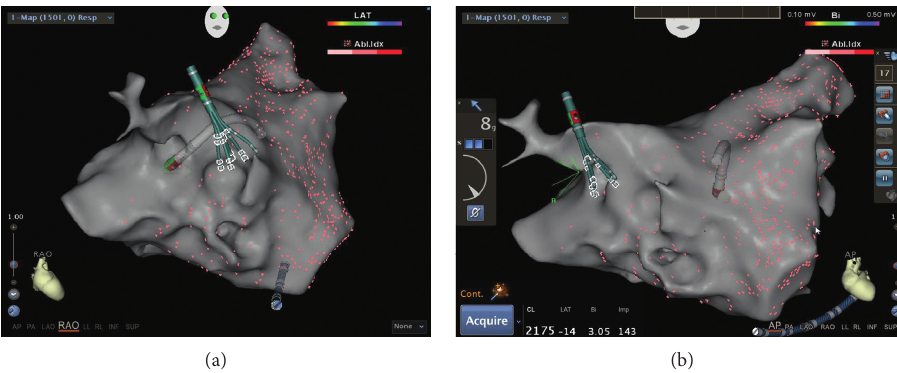
Figure 2: Establishing the left atrium model with a PentaRay catheter in a patient in the F group.